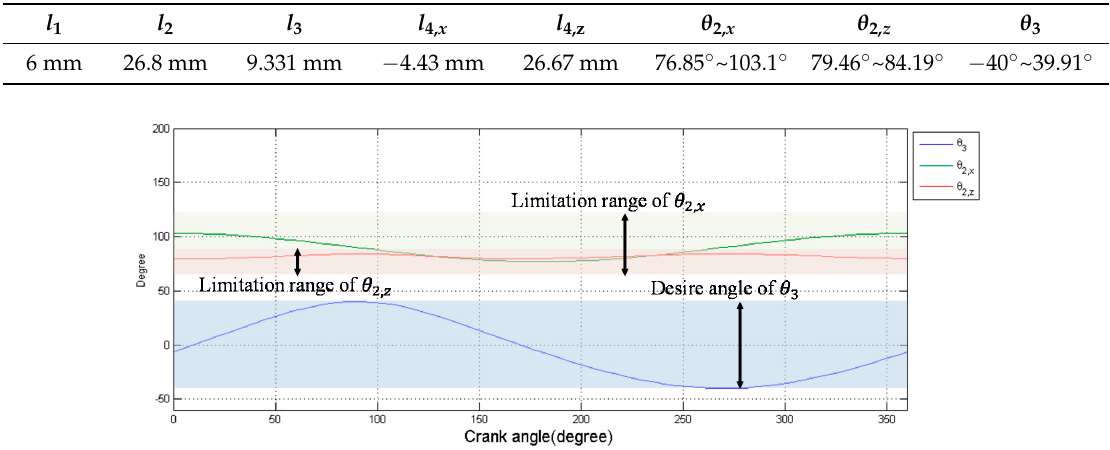
Table 3. Value of design parameters of the flapping mechanism.